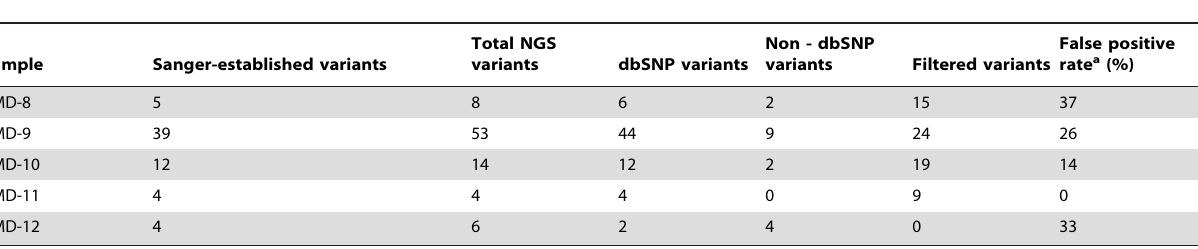
Table 5. Sequence variants identified by NGS sequencing in control samples.